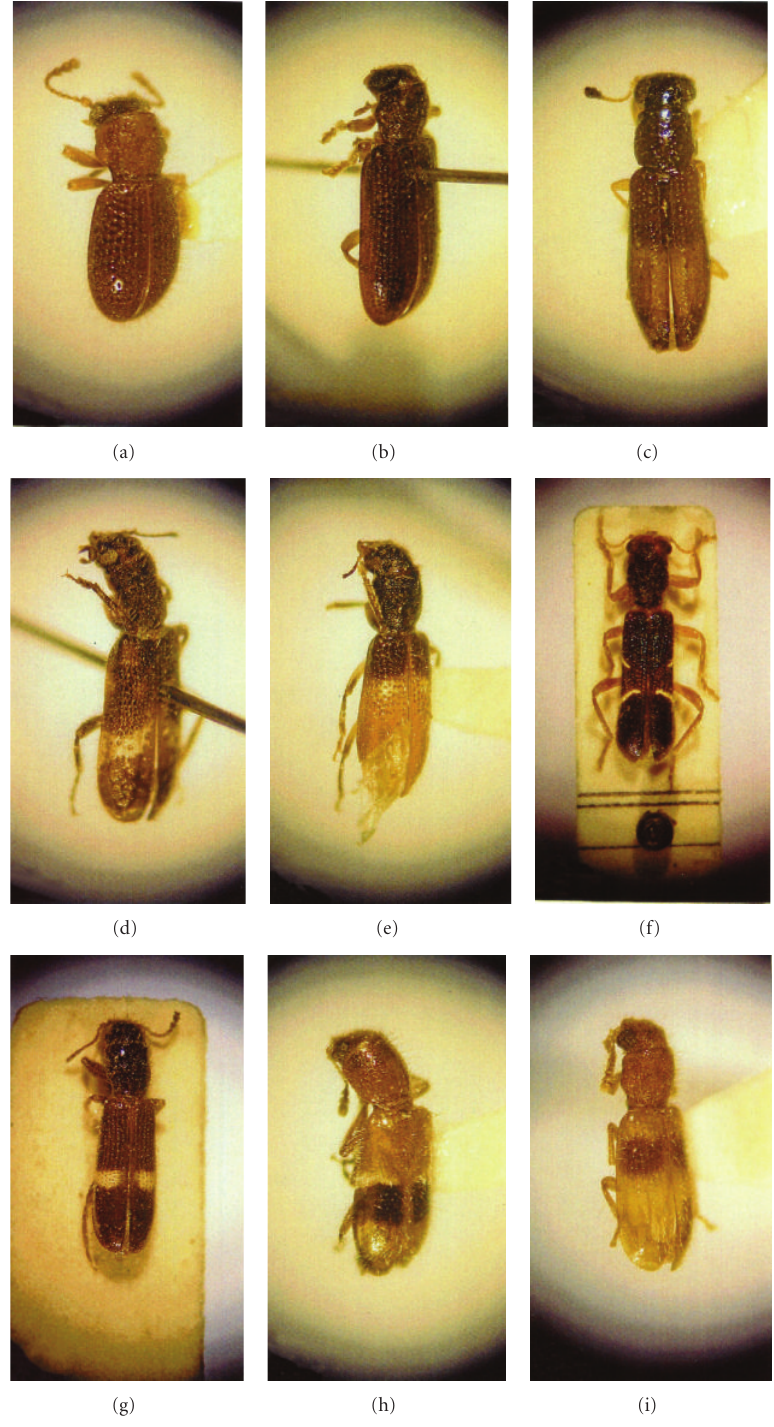
Figure 23: Habitus. (a) Pseudopylus okei . (b) Pylus fatuus . (c) Rhophaloclerus coquerelii . (d) Riotenerus fossipennes . (e) Tarsostenosis tricolor . (f) Tarsostenodes simulator . (g) Tarsostenus univttatus . (h) Thriocera pectoralis . (i) Thriocerodes bifasciatus